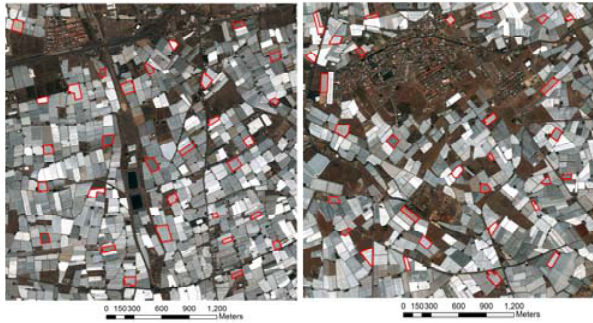
Figure 2. Reference greenhouse polygons in red digitized on R1 (left) and R2 (right) subareas.